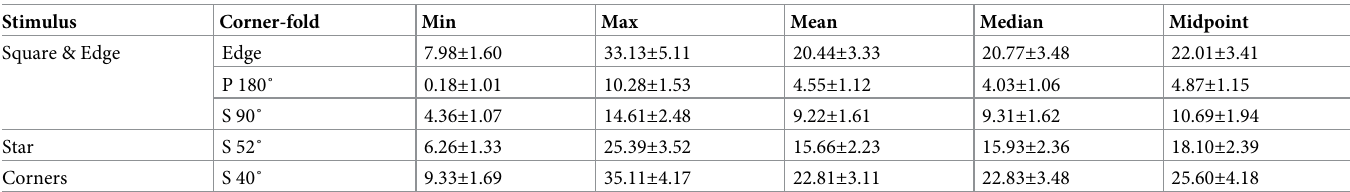
Table 1. Descriptive statistics of neural responses along edge and corner-folds. The minimum, maximum, mean, and median of the neural activity along the Edge and corner-folds are shown (mean ± SEM), along with the neural activity at the midpoints of the Edge and corner-folds. All values are computed from the spike rate difference map with units of spikes per